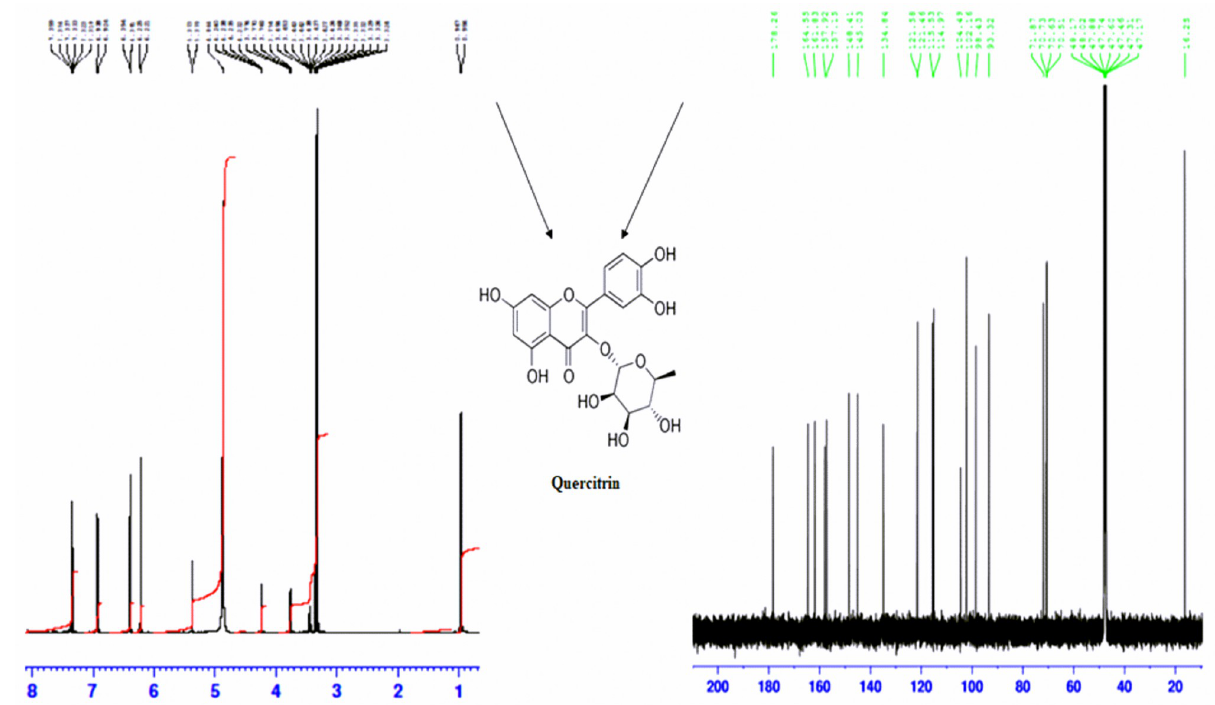
Fig 8. (A) 1 H-NMR, (B) C 13 -NMR spectrum and isolated compounds (C) Quercitrin of P-2 sample obtained from RP-HPLC of HWHF. Proton- decoupled natural abundance 1 H- NMR and C 13 - NMR spectrum of peak-2 sample of HWHF (obtained from chromatograph over the period of